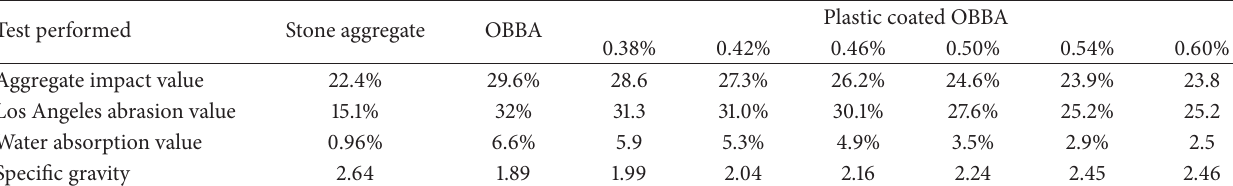
Table 2: Properties of aggregate.